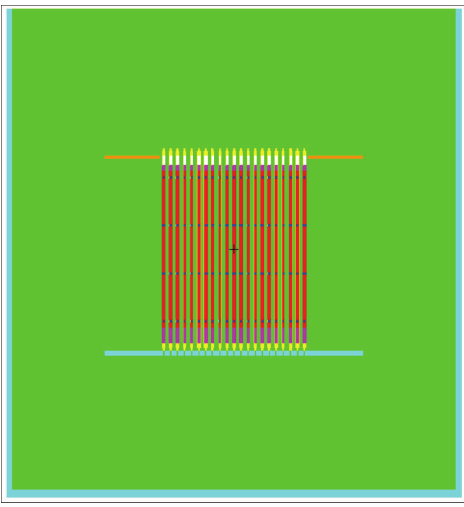
Figure3:MCNPmodeling x-z viewofJSAreactor,showingthecore in the water filled vessel.